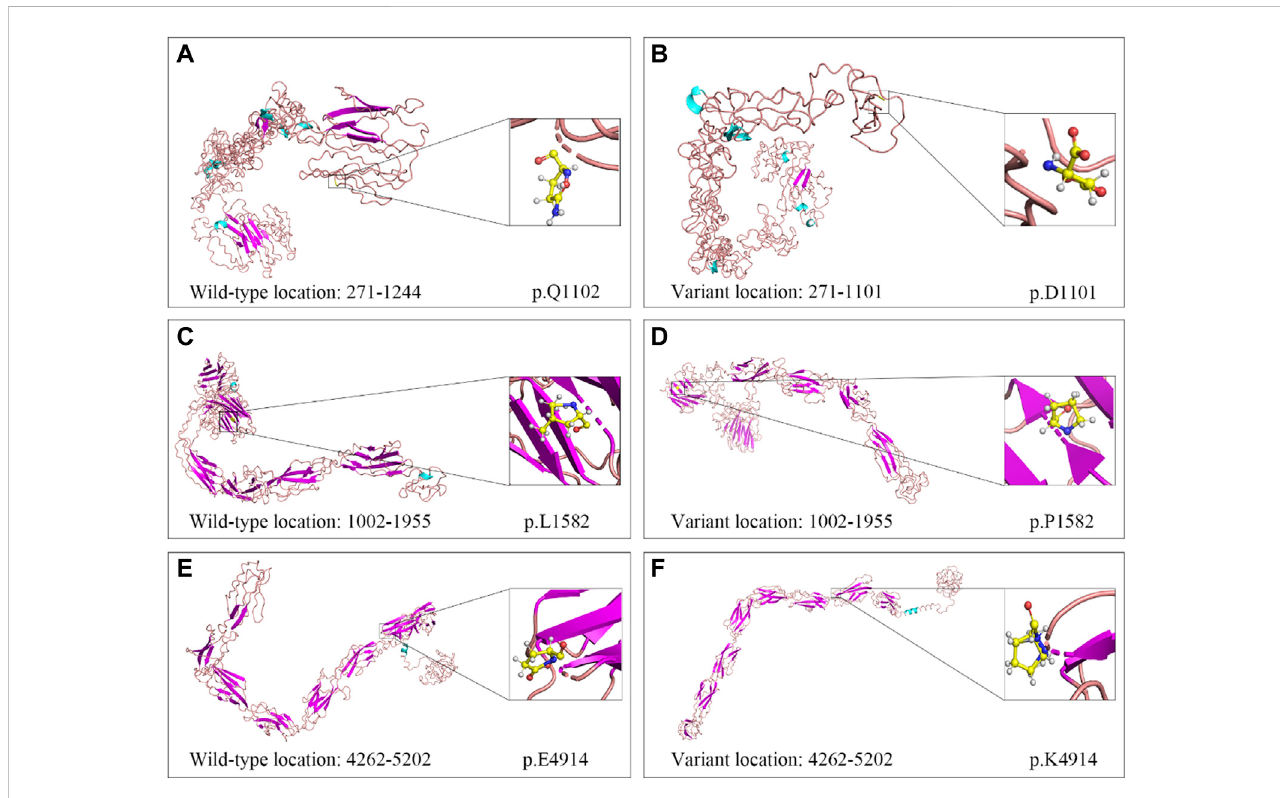
FIGURE 5 Cartoon models of wild-type and variant USH2A protein in three regions. (A, B) Segment 1 (amino acid 271 – 1,244): c.3304C > T (p.Q1102*). (C, D) Segment 2 (amino acid 1,002 – 1,955): c.4745T > C (p.L1582P). (E, F) Segment 3 (amino acid 4,262 – 5,202): c.14740G > A (p.E4914K).